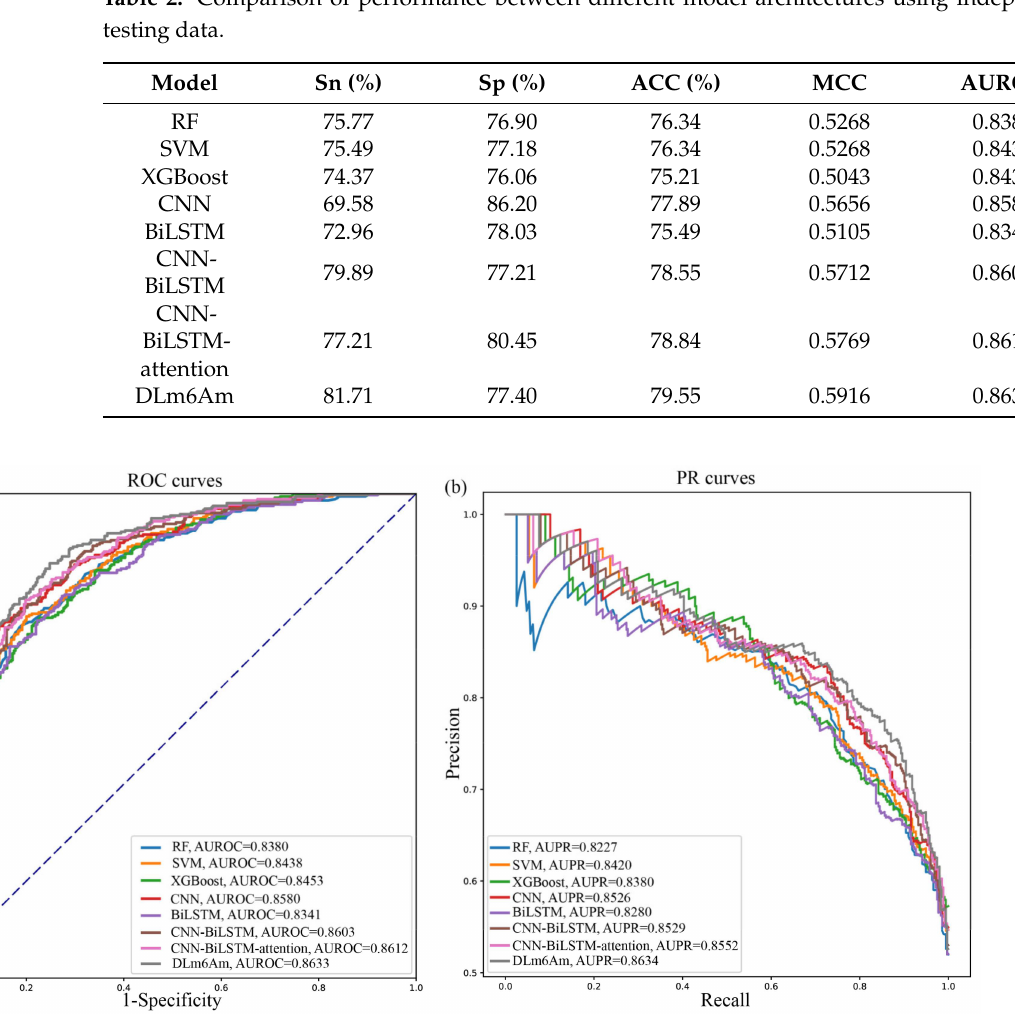
Table 2. Comparison of performance between different model architectures using independent